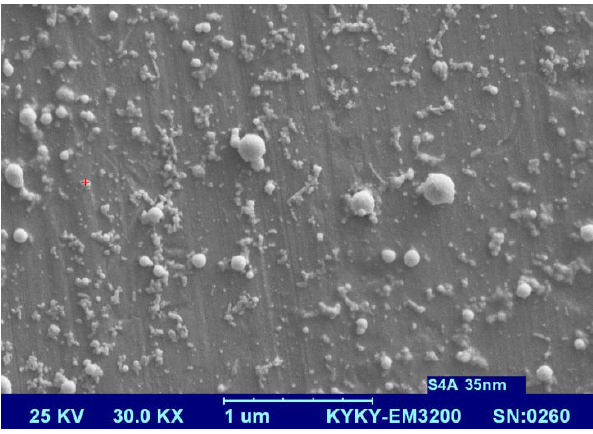
Fig. 1. SEM image of arc fabricated silver nanopowder (AgNP).